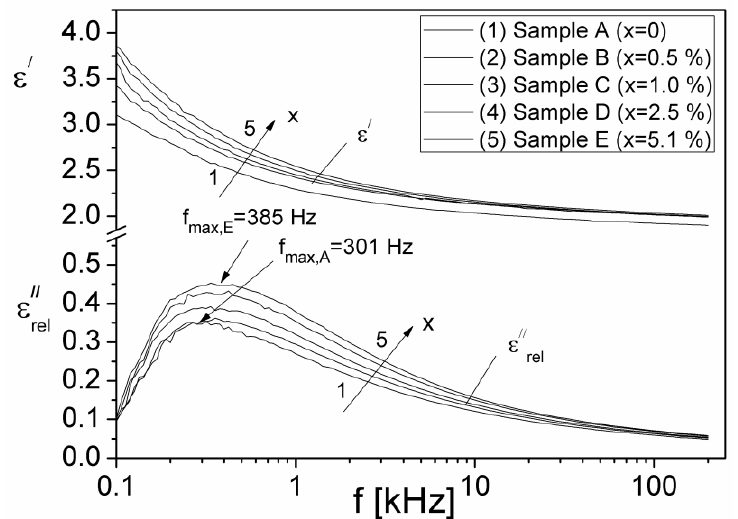
Figure 11. Frequency dependence of the real component ε (cid:48) and of the imaginary component ε (cid:48)(cid:48) rel due to the dielectric relaxation of samples.